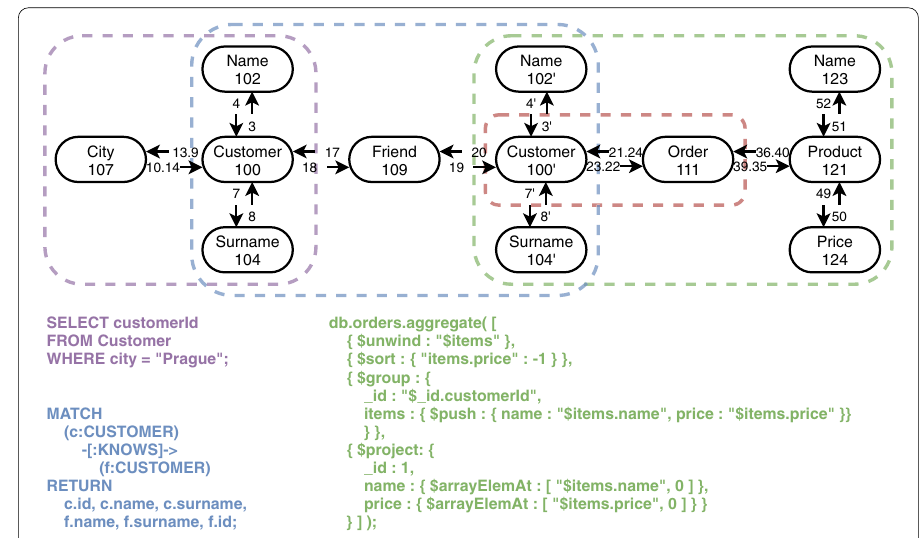
Fig. 16 The decomposition of projection pattern and examples of translations of corresponding query parts into particular